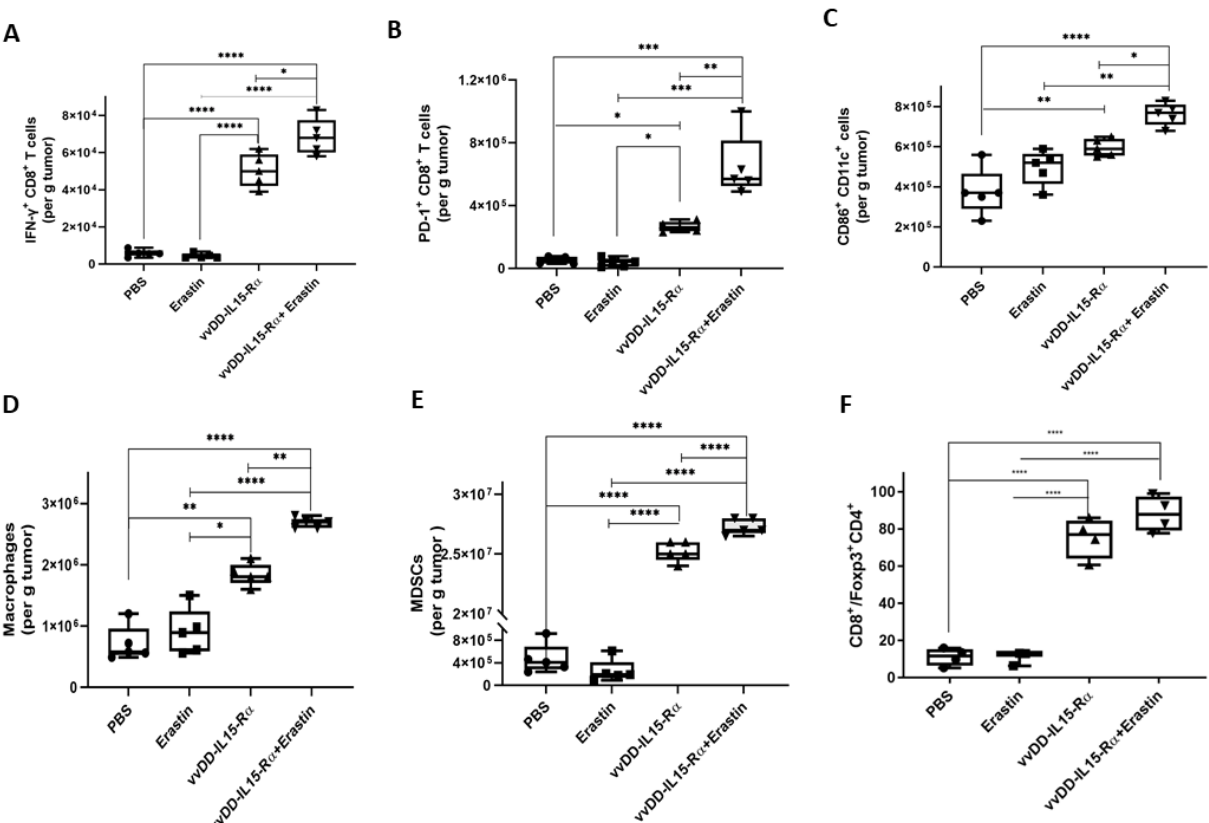
Figure 7. Tumor microenvironment (TME) is dynamically modified post combination therapy as analyzed by flow cytometry. Tumors are from the experiment depicted in Figure 5C, which were digested for FACS. ( A ) The quantities of activated IFN- γ+CD8+ T cells ; ( B ) PD-1 + CD8 + T cells; ( C ) activated CD86 + CD11c + cells; ( D ) macrophages (defined as CD45 + CD11b + F4/80 + CD206 + ); ( E ) myeloid-derived suppressor cells (defined as CD45 + CD11b + Gr-1 + ); and ( F ) The ratio of CD8 + /Treg (defined as CD45+CD4 + FOXP3 + ) cells. *, p < 0.05; **, p < 0.01; ***, p < 0.001; ****, p < 0.0001.